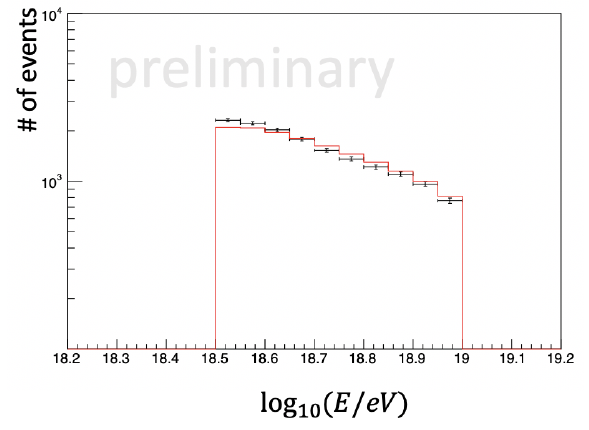
Figure 5. Energy distribution measured by the TA SD during 11 years (black points), compared to the time dependent detailed MC simulations (red histogram)